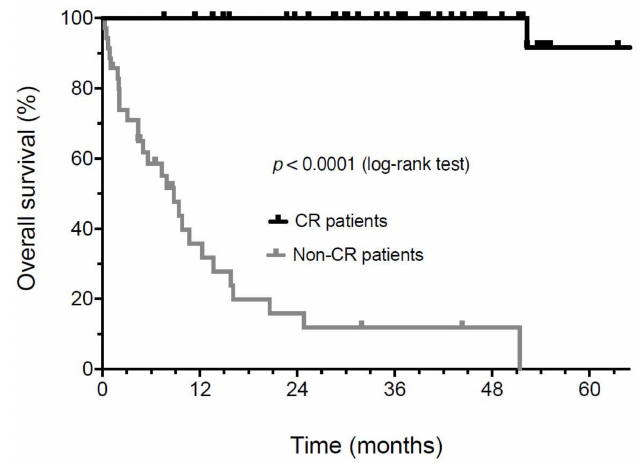
Figure 2. Kaplan-Meier analysis of overall survival from the time of treatment start in patients achieving a confirmed radiologic or pathologic CR compared to patients that never achieved com- plete remission.